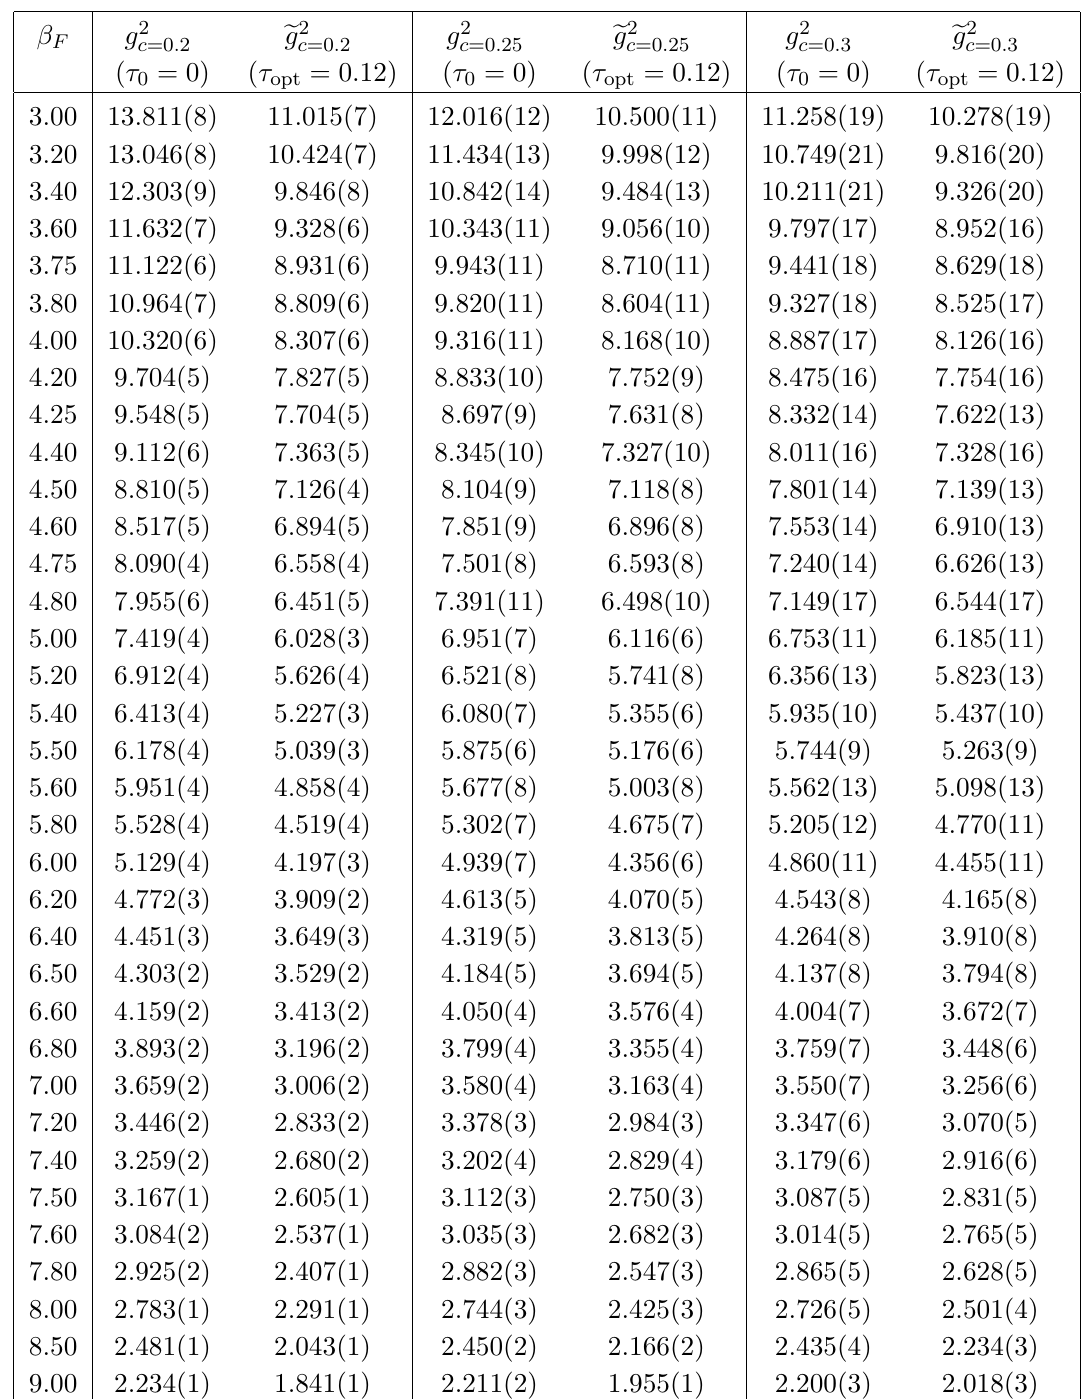
Table 16 . Renormalized gradient (cid:13)ow couplings based on the plaquette discretization of E ( t ) for the 16 4 lattice ensembles used in this work, with columns as in table